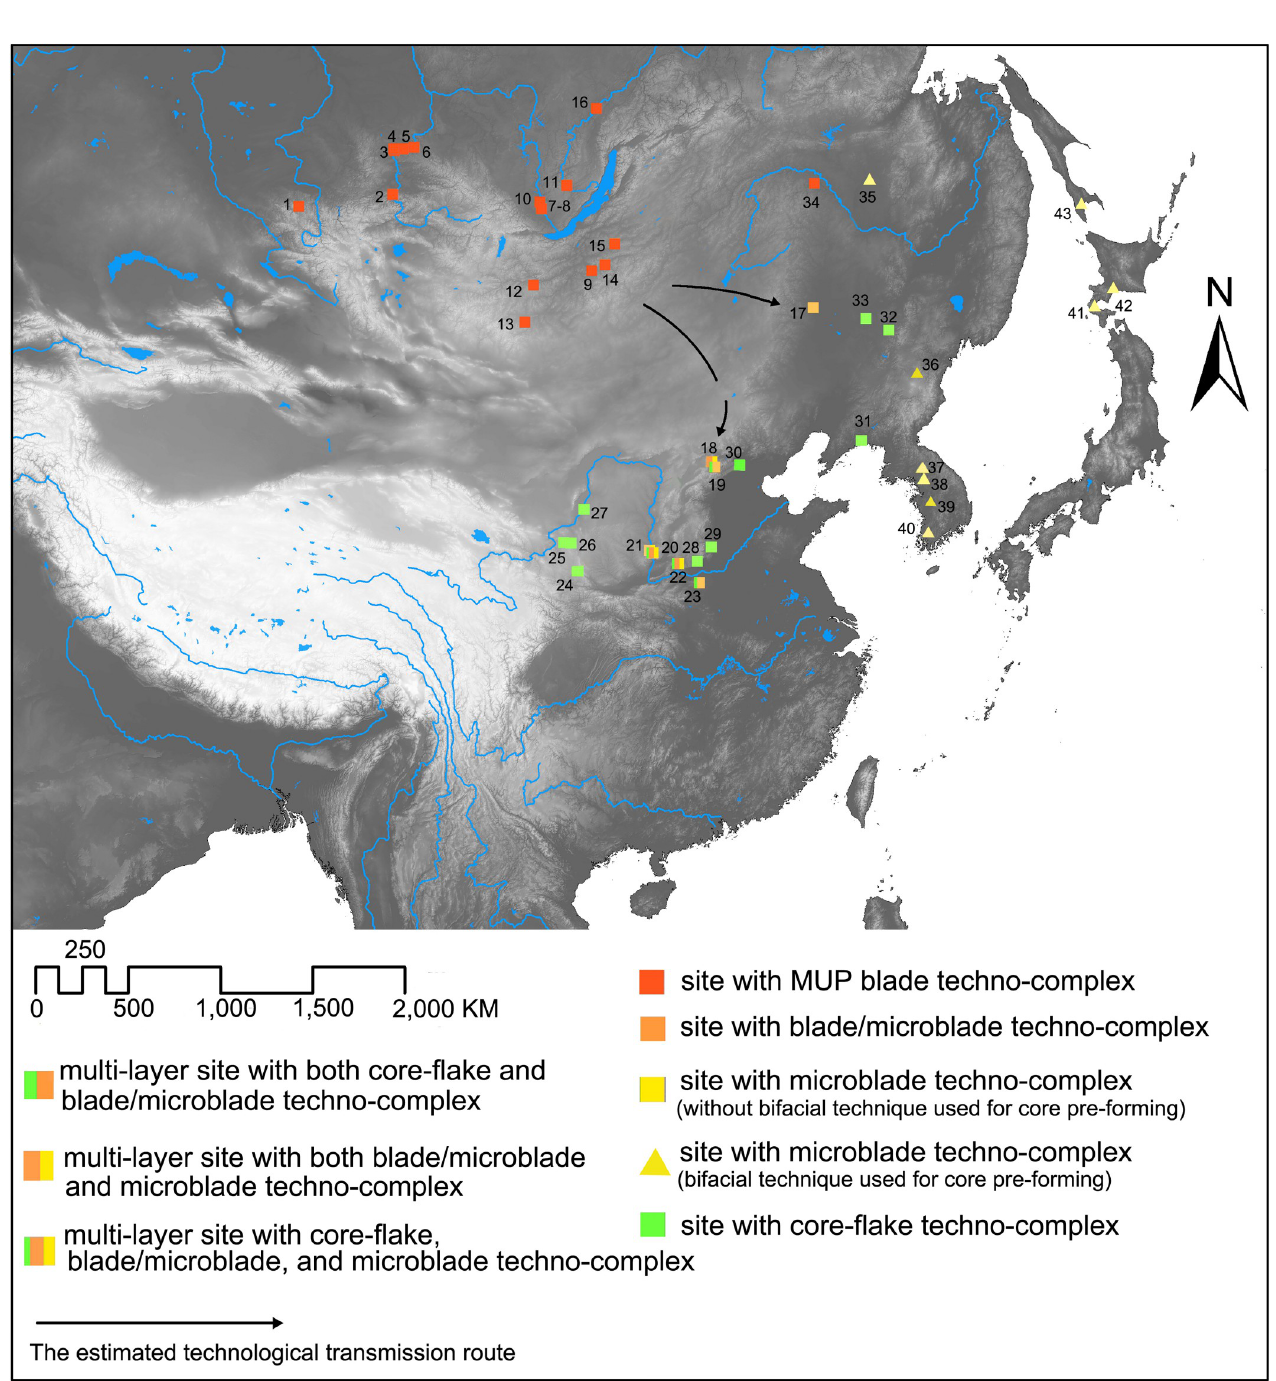
Fig 8. The distributional pattern of the sites with different techno-complexes and the estimated technological transmission route between northern China and Mongolia/Siberia during 32–23 cal ka BP. The base map raster is made from the USGS digital elevation map data from http://earthexplorer.usgs. gov/. (1: Anui-2; 2: Ui-l; 3: Sabanikha; 4: Novoselovo-13; 5: Kurtak-4; 6: Derbina-5; 7: Malta; 8: Buret’; 9: Chitkan; 10: Krasny Yar-1; 11: Shishkino-8; 12: Dorolj- 1; 13:Orkhon-7; 14: Priiskovoe; 15: Tolbaga; 16: Alekseevsk 1; 17: Xishantou; 18: Youfang; 19: Xishahe; 20: Shizitan-2929; 21: Longwangchan; 22: Xiachuan; 23: Xishi/Dongshi; 24: ZL05; 25: TX08; 26: TX03; 27: Shuidonggou-2; 28: Tashuihe; 29: Xiaonanhai; 30: Dongfangguangchang; 31: Miaohoushan; 32: Xuetian; 33: Yanjiagang; 34: Shibazhan; 35: Ust’-Ulma; 36: Dadong; 37: Jangheung-ri; 38: Hopyeong-dong; 39: Daejeong-dong; 40: Sinbuk; 41: Pirika-1; 42: Kashiwadai-1; 43: